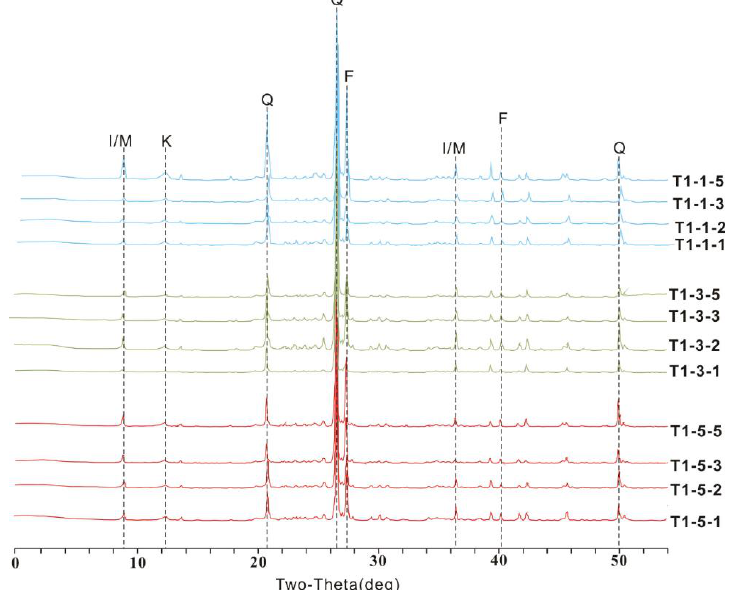
di ff erent di ff raction intensities of di ff erent crystal faces. Significant di ff raction peaks were also present at d = 3.24, 2.28, and 1.98 Å.